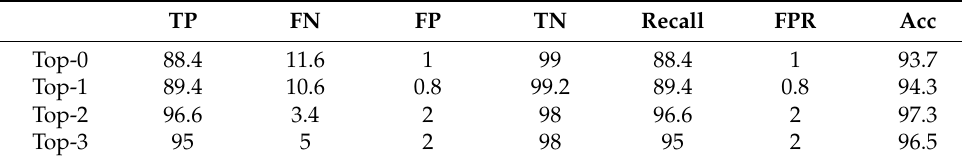
Table 1. Results according to the number of adjacent nodes.